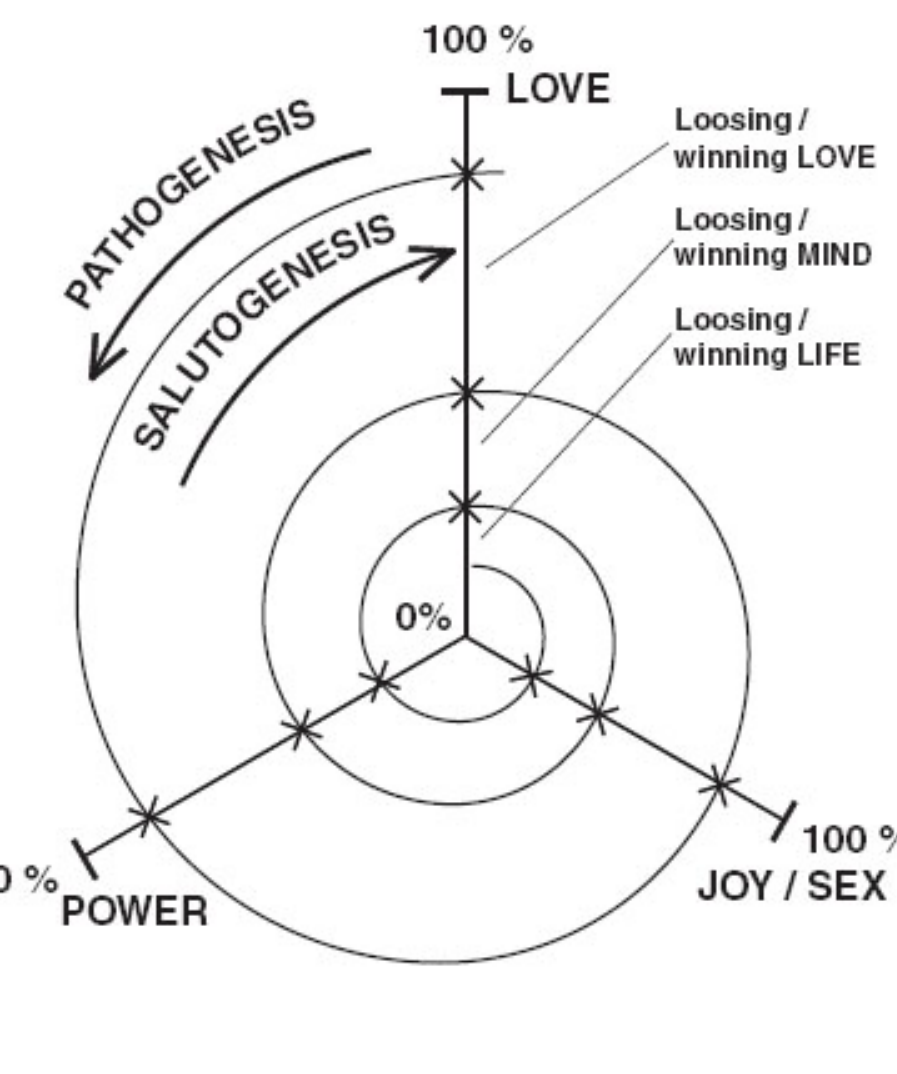
FIGURE 1. How the loss of existential responsibility causes insanity — theoretical model. If the three dimensions of love, power, and joy (from theory of talent[7]) are collapsed randomly, or if they collapse in parallel, we would somewhat have the pattern of a spiral or whorl, going from full responsibility for the three key dimensions down to zero. Responsibility can be defined as responsiveness to all experienced gaps, the gaps being between self and others, in self or in others, or even on the group level (in “the space”). (“X” represents a traumatic life event.)